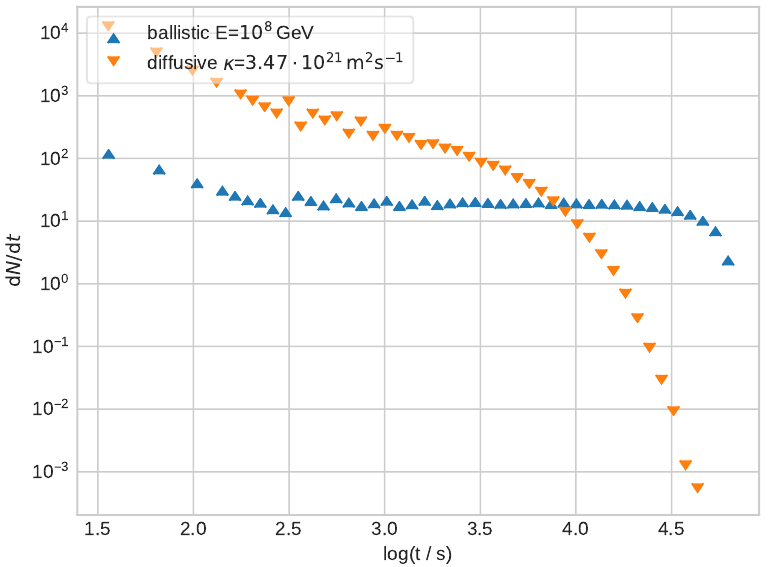
Figure 8. Cosmic-ray flare ( E = 10 8 GeV) from a blazar in the diffusive propagation model (orange downward triangle) and in the ballistic propagation model (blue upward triangle) as differential particle number per unit time d N /d t over time. The number of injected particles is N inj = 10 5